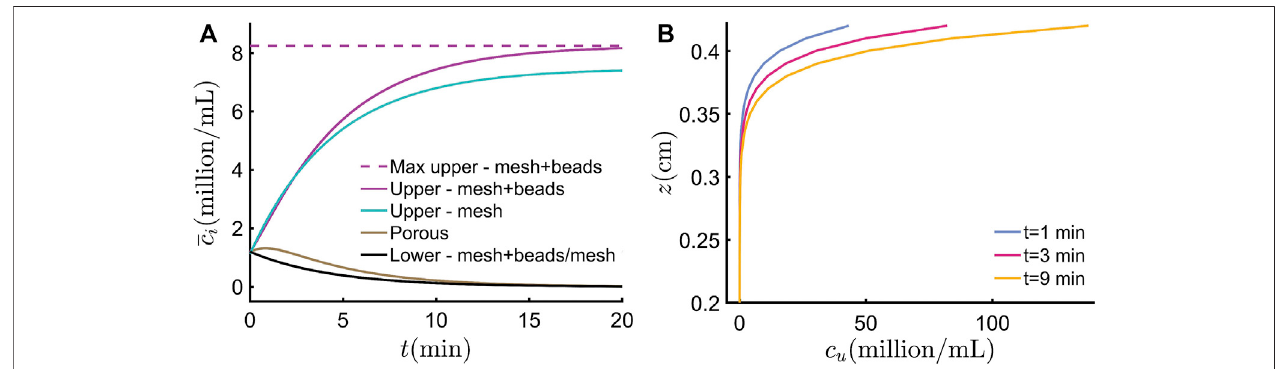
FIGURE 7 | Predictions of the essential model. (A) Average concentrations as a function of time since ‘ LED on ’ at t (cid:2) 0 in the upper, porous, and lower regions for the mesh + beads case, and upper and lower regions for the mesh-only case. For both cases, phototactic concentration causes the lower region to evacuate and the upperregionto fi llupwithswimmers,uptoamaximumlimit,asdiscussedinthetext.Forclarity,thislimit,shownasadottedlineforthemesh+beadscase,isnotshown for the mesh-only case. (B) Spatial swimmer concentration pro fi les in the upper region at different times, as shown. The suspension becomes increasingly top- heavy. The plot starts at z (cid:2) 0.2 cm to make the pro fi les more evident (the concentration predicted below this level is 0 cells/ml).